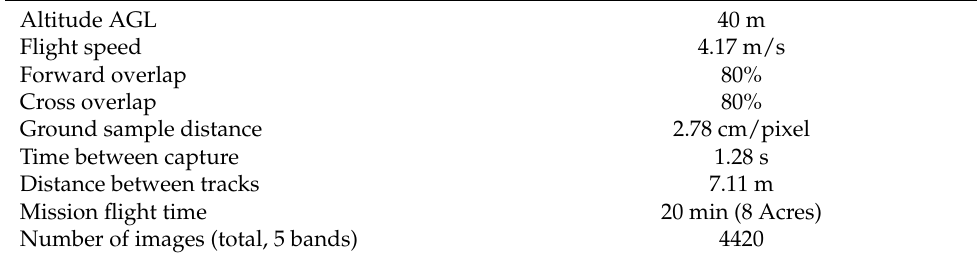
Table 2. UAS Mission parameters.